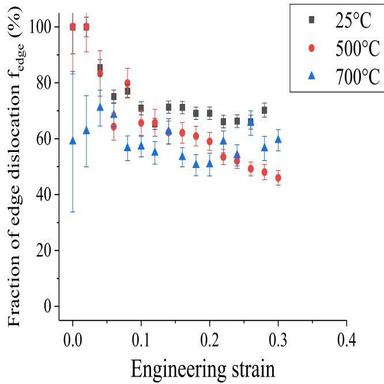
Fraction of edge dislocation character during tensile tests at different temperatures.